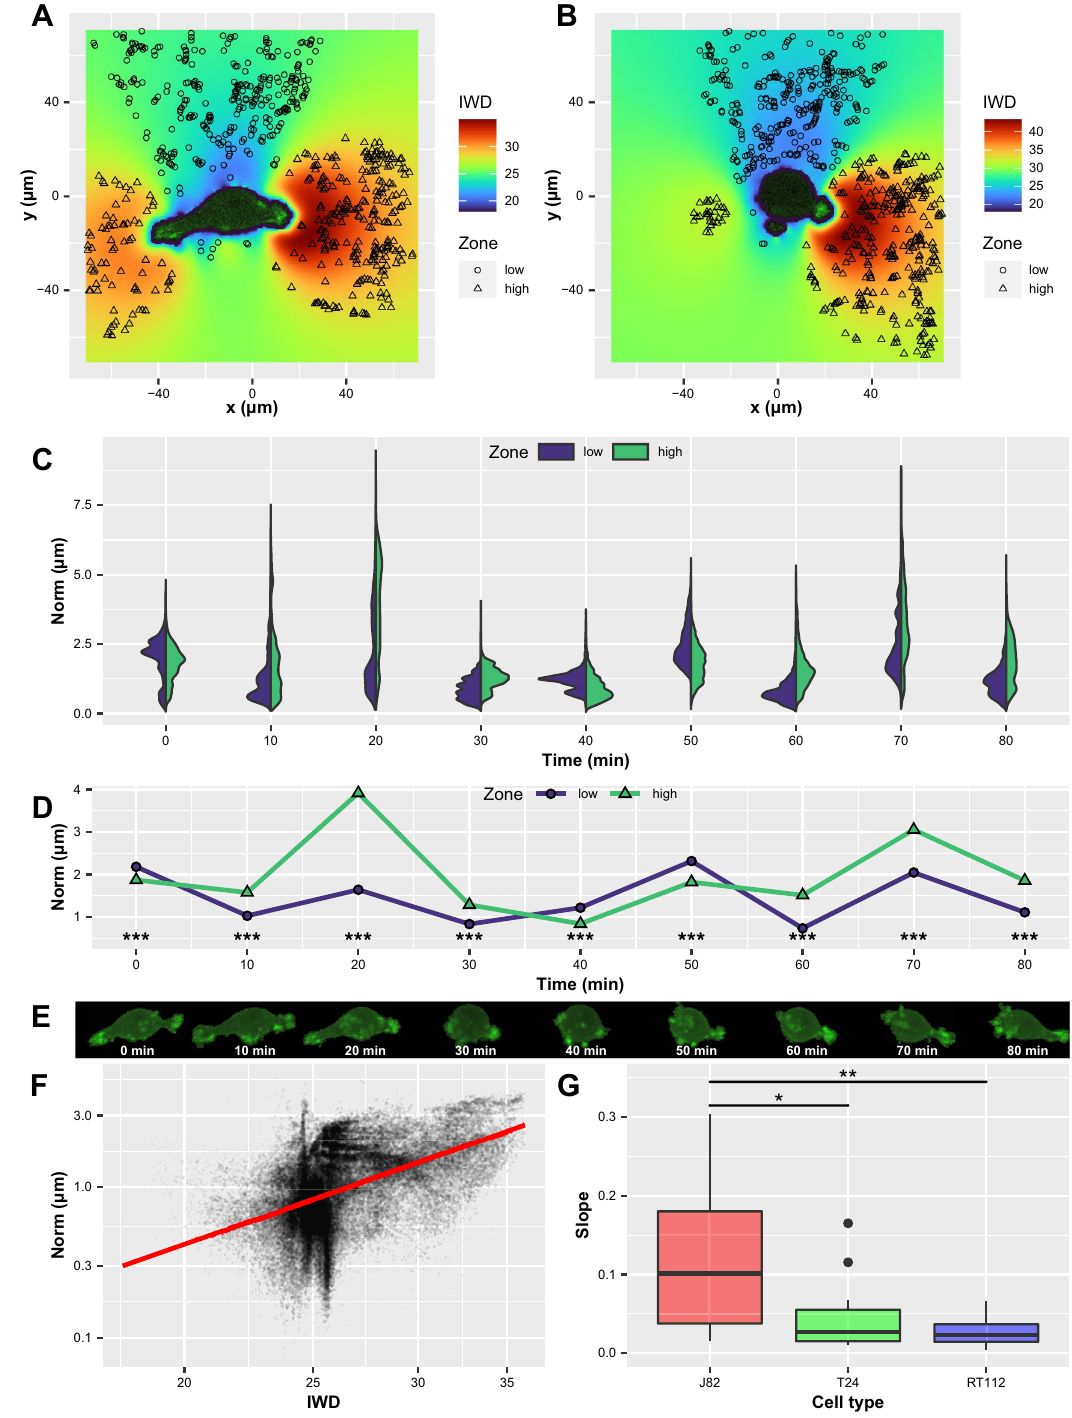
Figure 5. Correlation between actin intensities and displacement magnitudes (J82 cell). ( A , B ) Values of IWDs are shown at two different times, 20 min, and 30 min. Symbols represent low and high IWDs, respectively [0–25%] and [75–100%] ranges. ( C ) Violin plots of the displacement norm distributions corresponding to low (blue) and high (green) IWD values in time. ( D ) Median of the norms (low and high IWDs) vs. time, with significant difference from Kruskal-Wallis test. ( E ) Corresponding cell shapes. ( F ) Displacement norms vs. weighted actin intensities (IWD) for t = 20 min. The red line is the regression curve. ( G ) Slopes of regression curves at times for which Norm high /Norm low > 1, for the three cell types. Significance of Kruskal-Wallis test, followed by Dunn’s test with Bonferroni